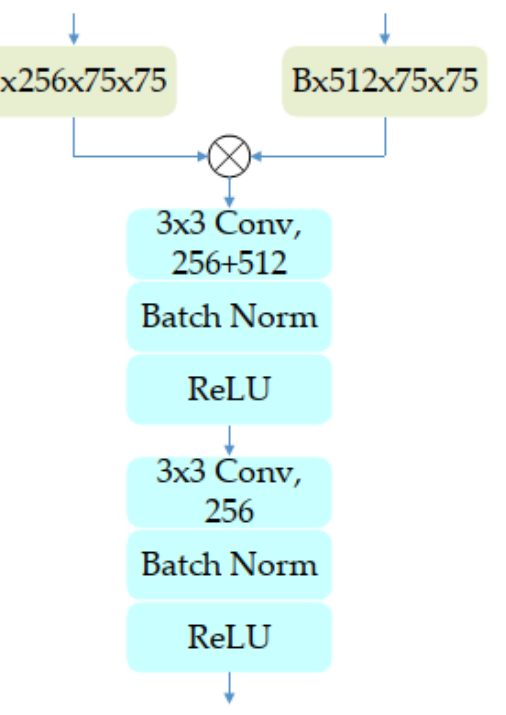
Figure 3. The structure of the OFFM. The yellow parts are the size of the input feature map. The blue parts are the internal compositions of the OFFM. B is the batch size. The figure shows that the 256 input channels of the upper-layer and the 512 input channels of the lower-layer are convoluted by 3 × 3 kernels. Finally, a 256-channel output feature map is generated by 3 × 3 convolution.